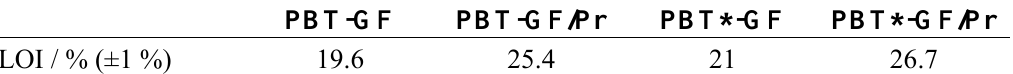
Table 8. LOI of PBT-GF